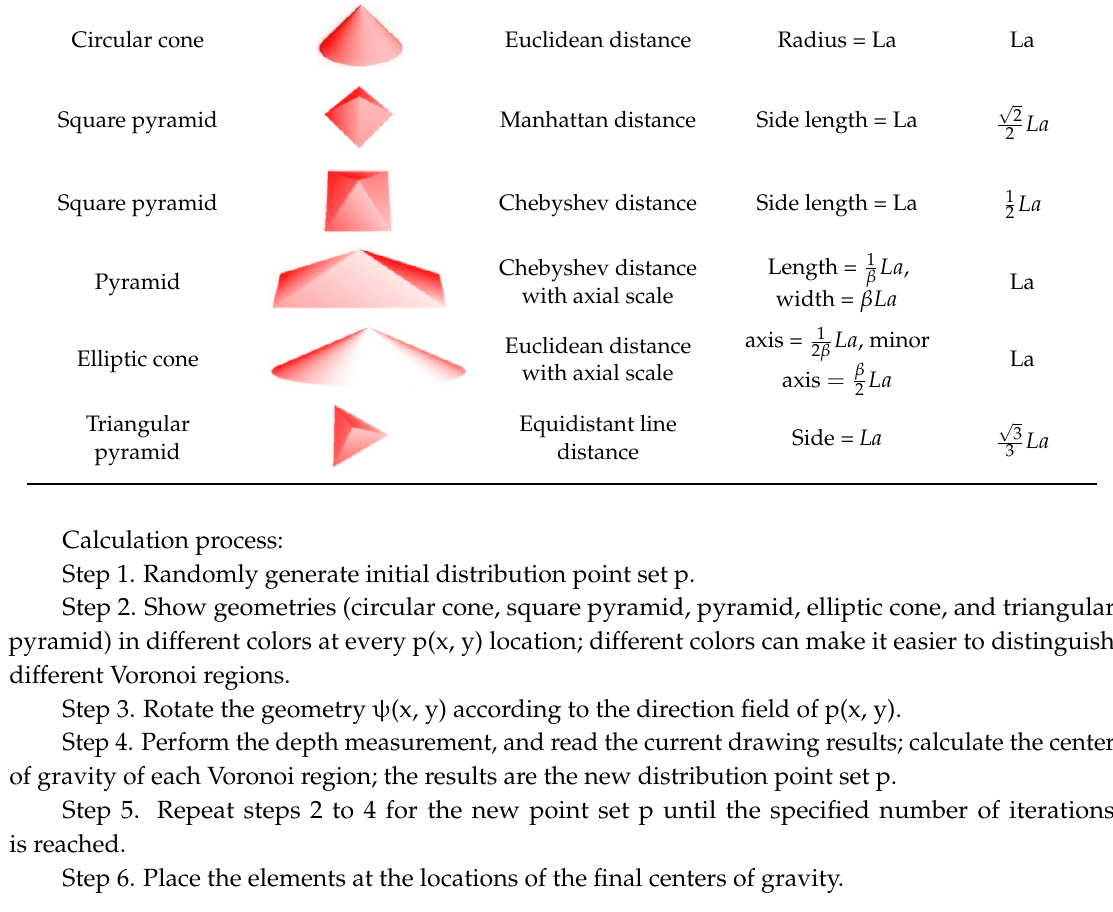
Table 1. Shapes and sizes of geometries corresponding to different distance metrics.